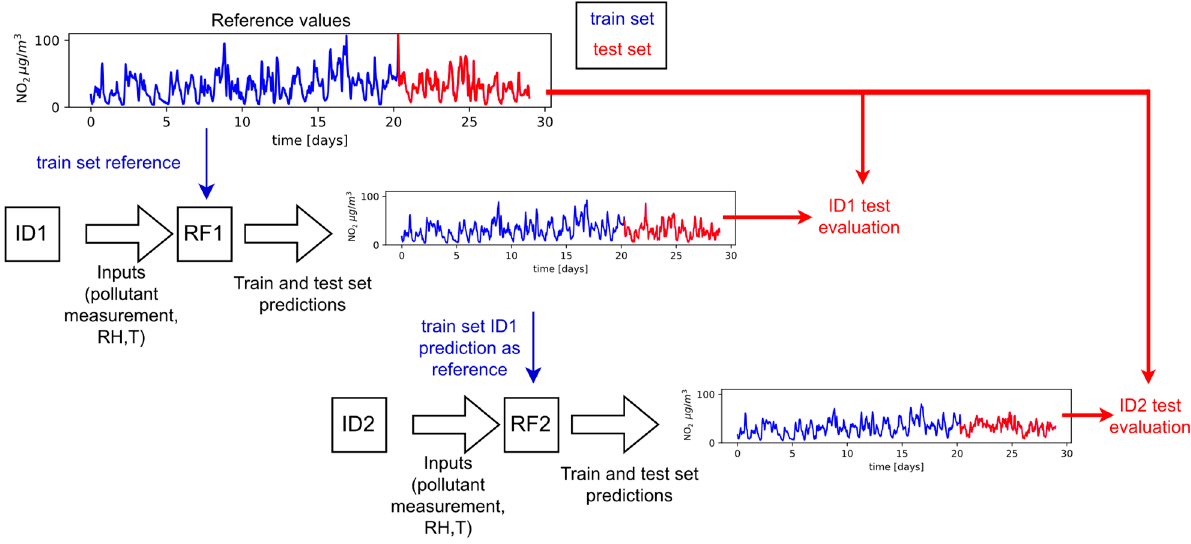
Figure 4. Illustration of the calibration propagation process and evaluation for devices ID1 and ID2.